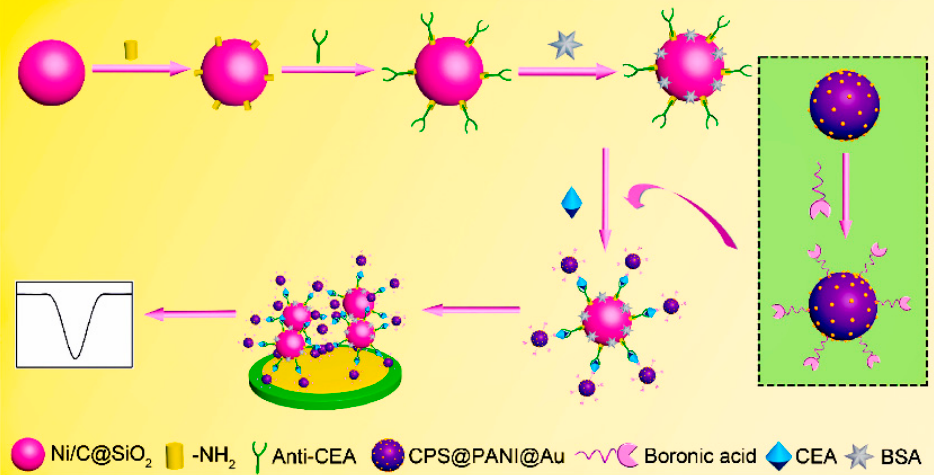
Figure 13. Diagrammatic representation of the steps involved in creating a sandwich–style electro- chemical biosensor [100]. Copyright (2021) Elsevier.